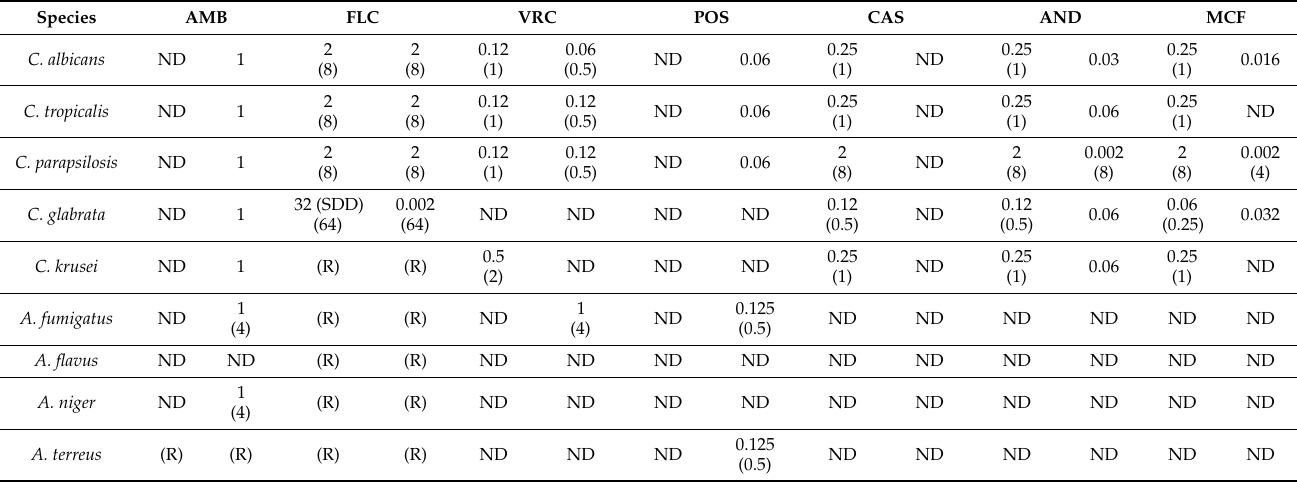
Table 1. Comparison of CLSI and EUCAST clinical breakpoints of antifungal drugs for most relevant Candida and Aspergillus spp. according to CLSI and